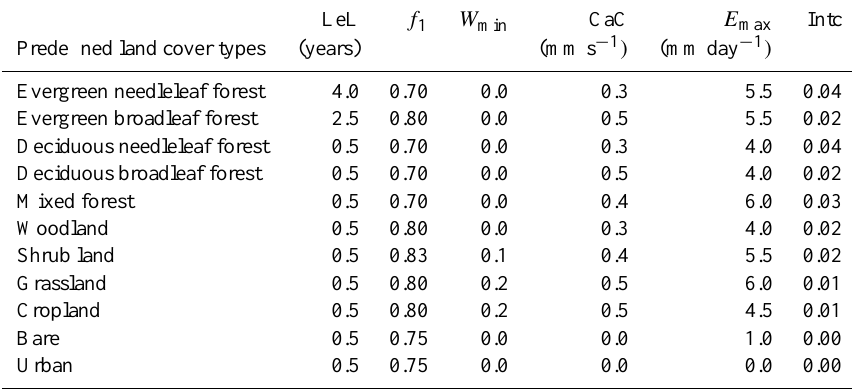
Table 2. Photosynthetic relevant parameters for predefined land covers. Predefined land cover types Evergreen needleleaf forest Evergreen broadleaf forest Deciduous needleleaf forest Deciduous broadleaf forest Mixed